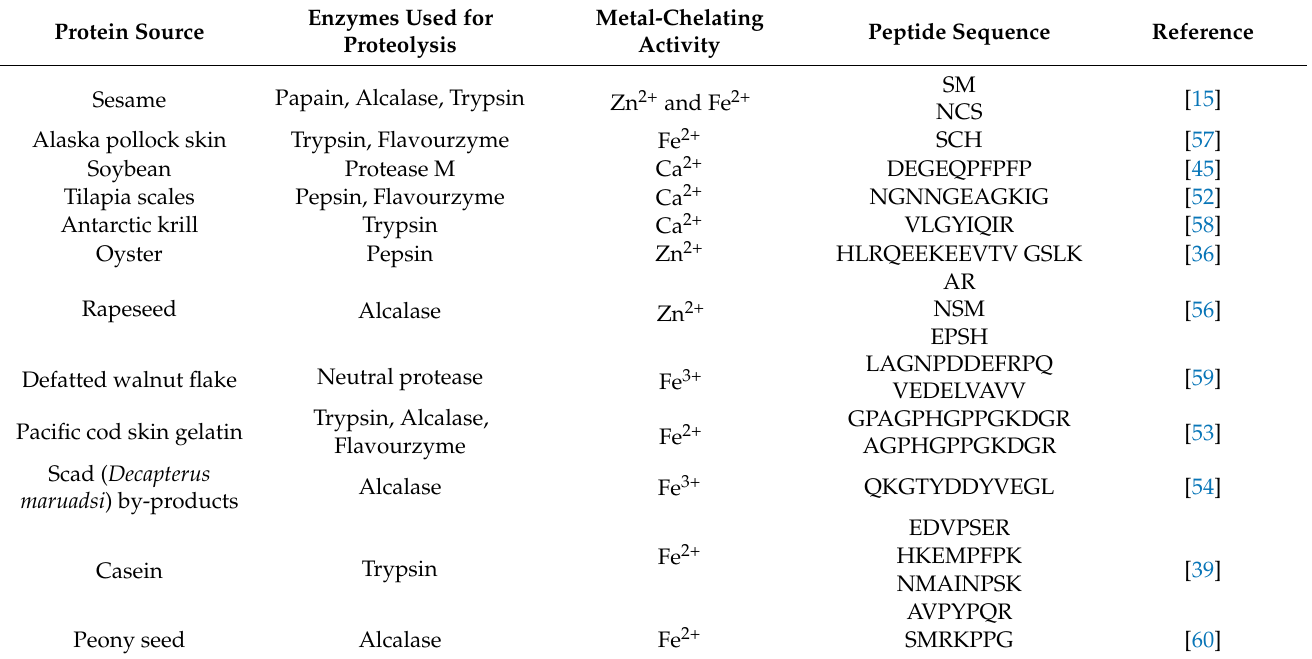
Table 1. Examples of metal-chelating peptides produced from different food protein sources, pro- teases used for hydrolysis and chelated